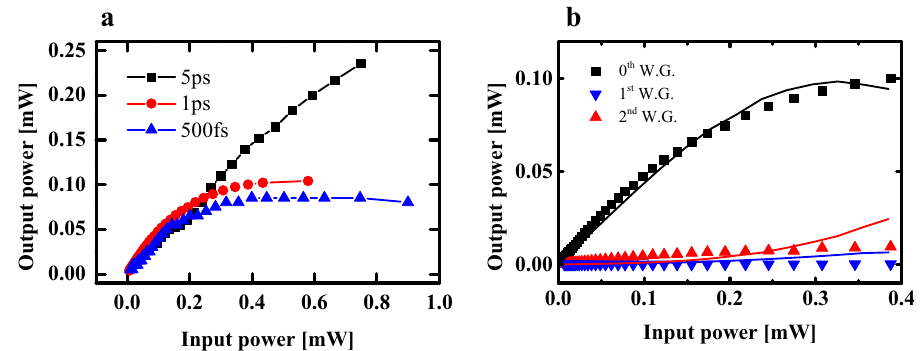
Fig. 4 | Experimentally observed output power saturation in the topological boundary waveguide. a The output power versus input power at different tem- poral pulse widths of 5, 1ps, and 500fs. b The output power of 1ps pulses at the to saturate at an input average power of 0.42 and 0.30mW, respec- tively (Fig.4a).Wenotefurtherthatthisobservedsaturationcannot be